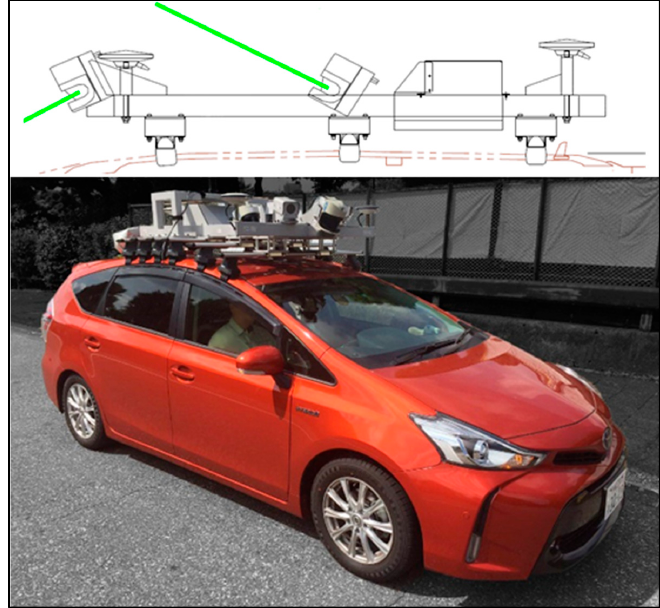
Figure 17. MMS system description: Mitsubishi Electric’s MMS-K320 ( bottom ); and the configuration of two SICK LMS-511 laser scanners and RTK GPS receivers ( top ).